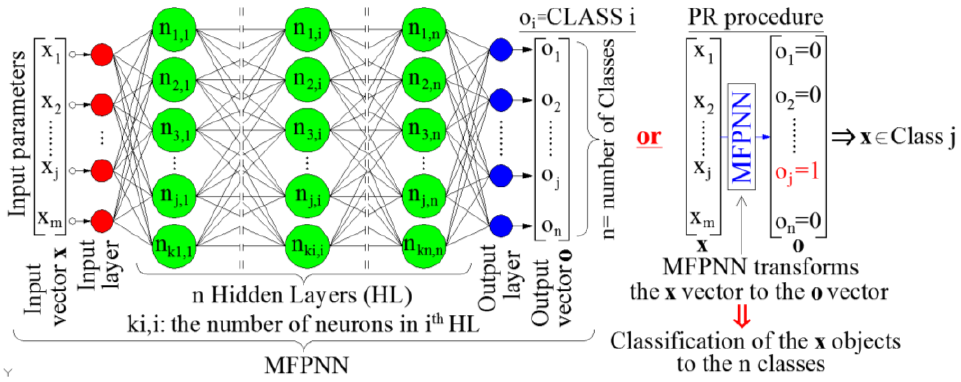
Figure 1. General description of the configuration of an MFPNN used for the solution of PR prob-